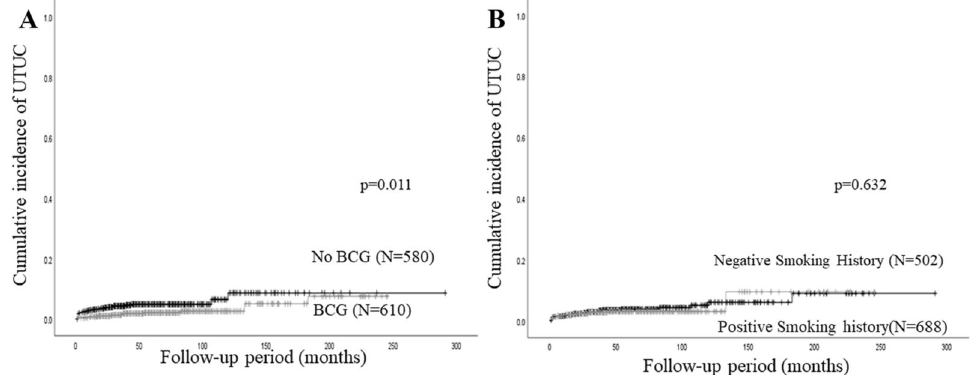
Figure 1. Cumulative incidence of UTUC recurrence in all NMIBC patients stratified by a history of BCG therapy ( A ) and the presence or absence of a smoking history ( B